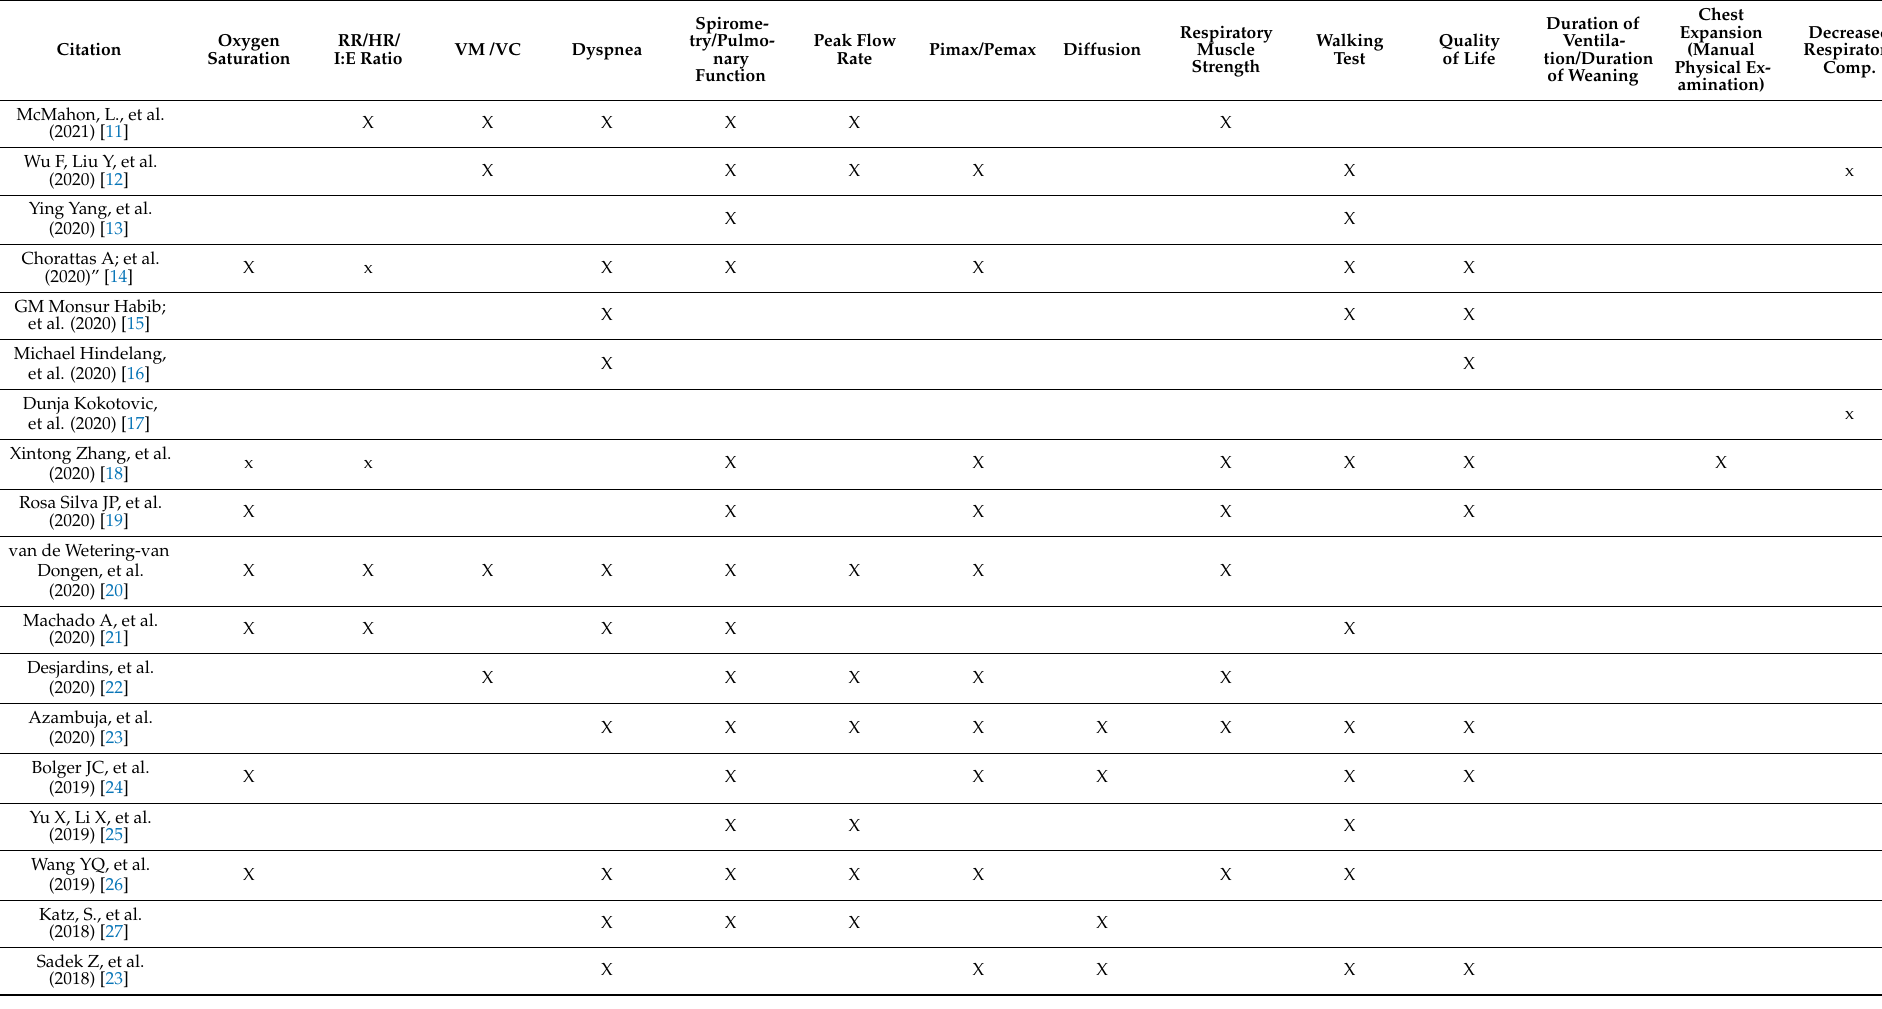
Table 3. Impact of interventions included in systematic reviews on compromised